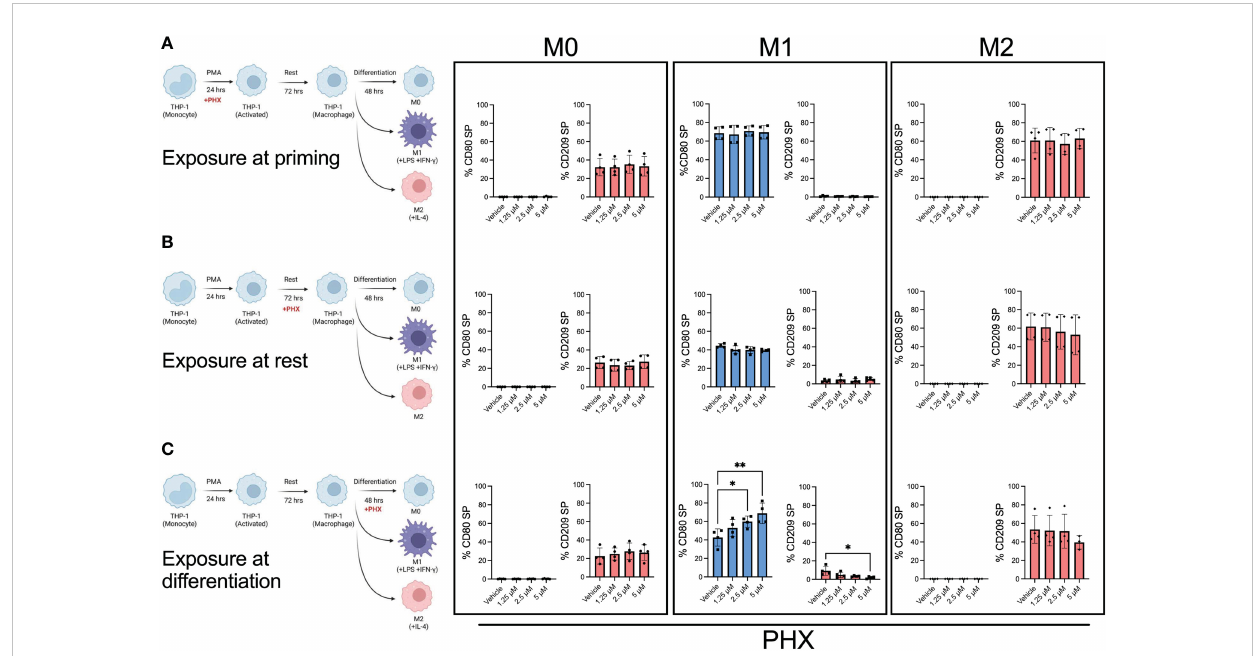
FIGURE 2 M1 promotion by PHX occurs during the differentiation stage. PHX was added at either (A) priming, (B) resting or (C) differentiation stage of the macrophage culture. Schematic diagram describing where PHX was added and quanti fi cation of % CD80 (blue) single positive (SP) and % CD209 (pink) SP between M0, M1 and M2 differentiation conditions. Data are pooled from two independent experiments with duplicates and presented as mean ± SD of pooled replicates. One-way ANOVA with Dunnett's multiple comparisons test was performed for the analysis * p ≤ 0.05; ** p ≤